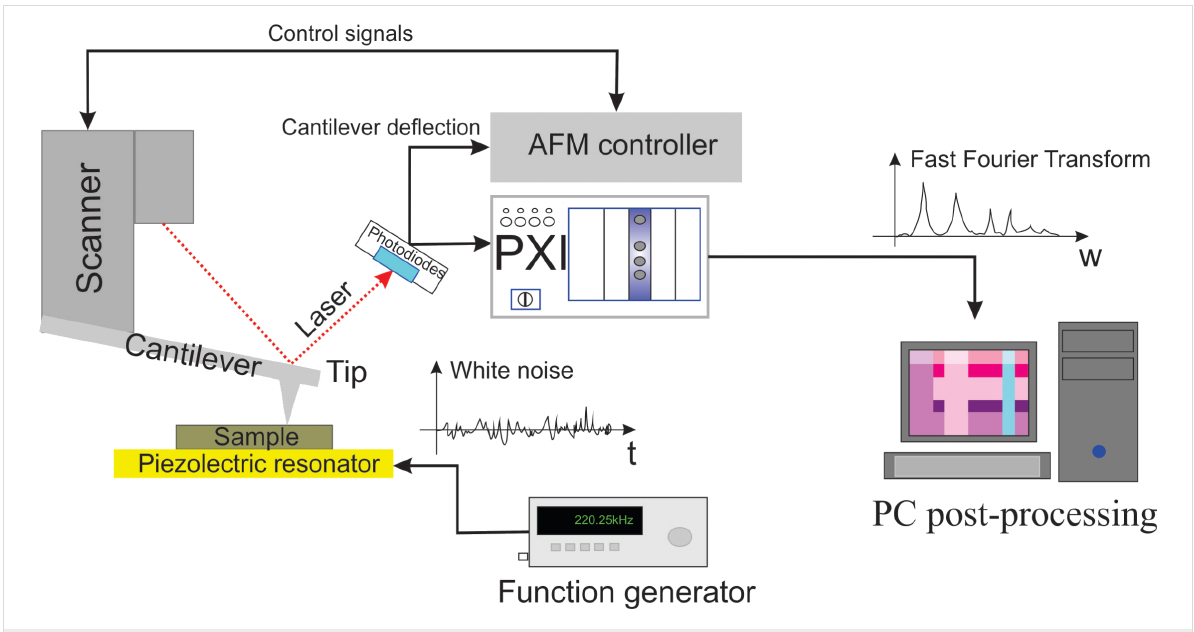
Figure 1: Experimental setup for S-AFAM, using a NI PXIe-1073 device and a function waveform generator HP/Agilent